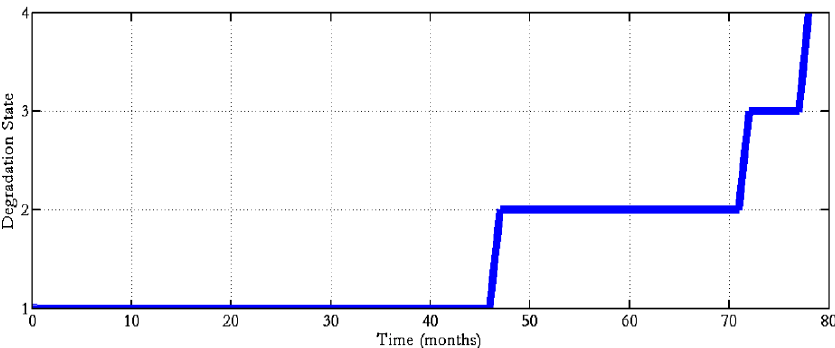
Figure 3. Example of simulated degradation trajectory.